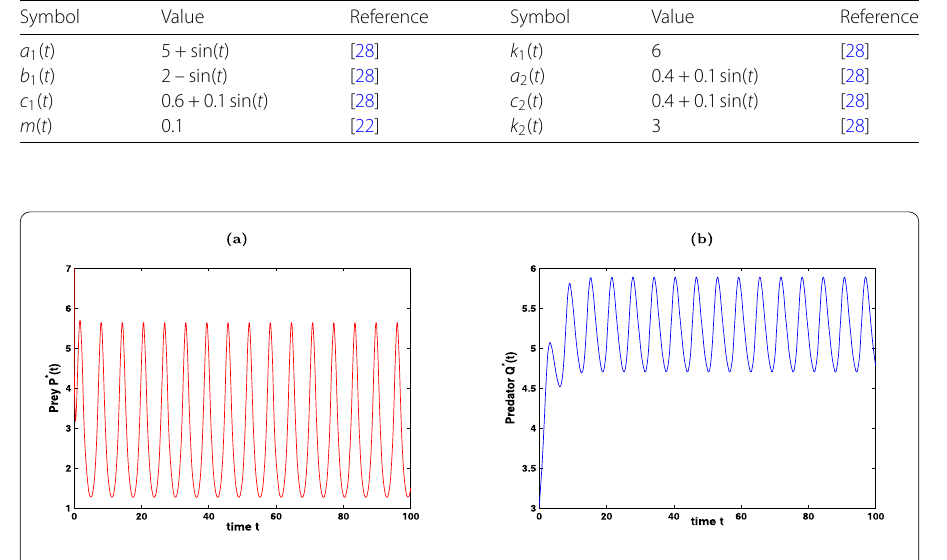
Figure 1 The periodic solution ( P ∗ ( t ), Q ∗ ( t )) with initial values P (0) = 7, Q (0) = 3. ( a )–( b ): the densities of prey P ∗ ( t ) and predator Q ∗ ( t